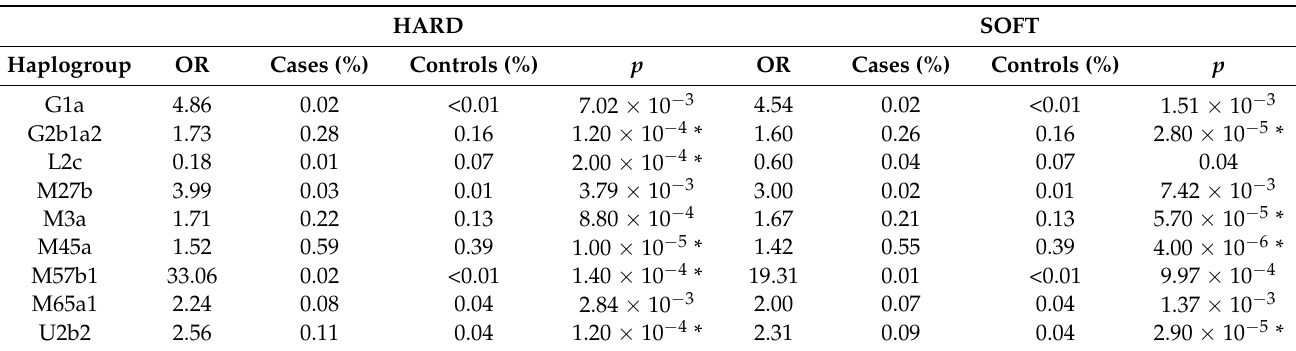
Table 5. Haplogroup assignment in HARD and SOFT CAD cases vs. controls prior to further assigning individuals to one of the major European haplogroups. * Indicates that a haplogroup survived multiple testing correction (at FDR < 5%).